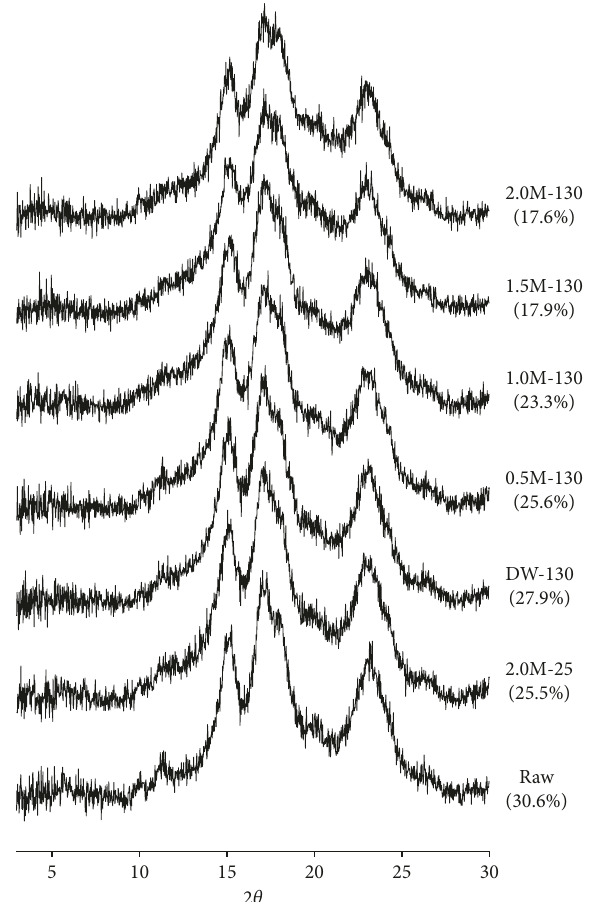
Figure 3: X-ray diffraction patterns and relative crystallinity of raw and malic acid-treated sweet potato starches. Numbers in paren- theses indicate the percentage of